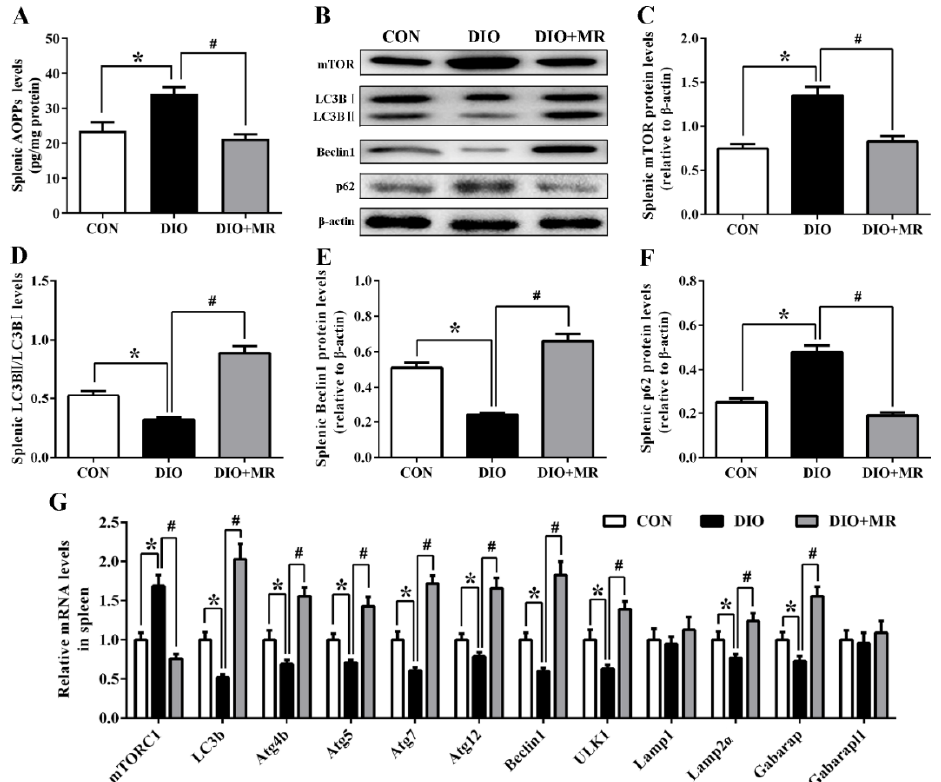
Figure 9. Effects of MR on splenic AOPPs levels ( A ), autophagy-related protein bands ( B ), splenic mTOR protein levels ( C ), splenic LC3BII/LC3BI levels ( D ), splenic Beclin1 protein levels ( E ), splenic p62 protein levels ( F ), and autophagy pathway-related mRNA levels ( G ) in obese mice. AOPPs, advanced oxidation protein products; mTOR, mammalian target of rapamycin; LC3B, Microtubule-associated proteins light chain 3B; p62, sequestosome; mTORC1, mammalian target of rapamycin complex 1; ATG4b/ATG5/ATG7/ATG12, Autophagy related genes; ULK1, unc-51-like kinase 1; Lamp1/Lamp2 α , lysosome-associated membrane protein; Gabarap, gamma-aminobutyric acid receptor-associated protein; Gabarapl1, Gabarap-like 1. All data are shown as mean ± SEM ( n = 10). * p < 0.05 versus CON; # p < 0.05 versus